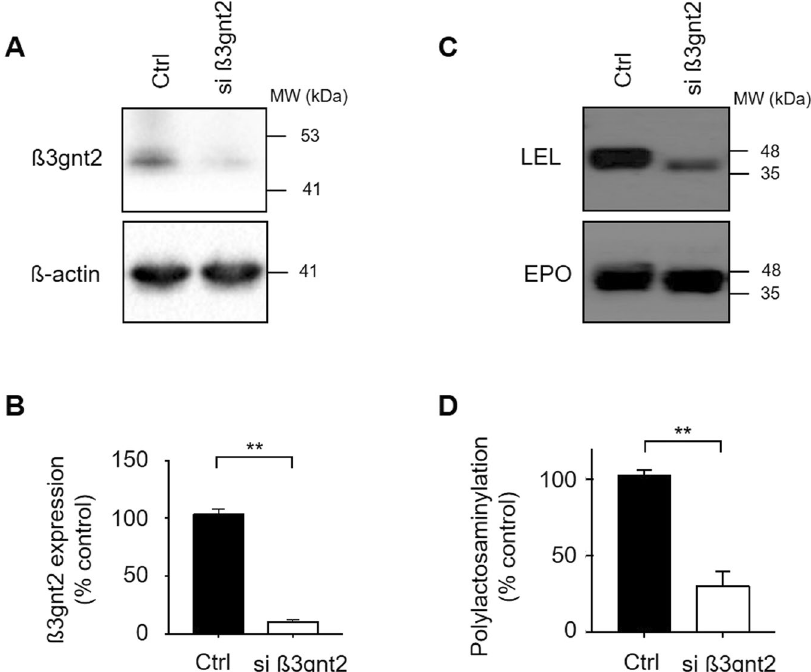
Figure 2. Decreased poly-LacNAc via β 3gnt2 knock-down. ( A ) Depletion of β 3gnt2 by siRNA was determined by western blot. Lane 1, EC2-1H9 cells. Lane 2, EC2-1H9 cells treated with siRNA against β 3gnt2. ( B ) Quantification of panel A using Image J. The band intensities of β 3gnt2 were normalized by the intensities of β -actin. ( C ) Lectin blot results show reduced polylactosaminylation of rhEPO purified from β 3gnt2 - depleted CHO cells. For detection of polylactosaminylation, 1 μ g of purified rhEPO was used. ( D ) Quantification of the data in C. LEL lectin band intensities were normalized by EPO band intensities. The data shown are presented as means ± S.E.M. from three independent experiments each with duplicate samples. ** P < 0.01 (Student’s